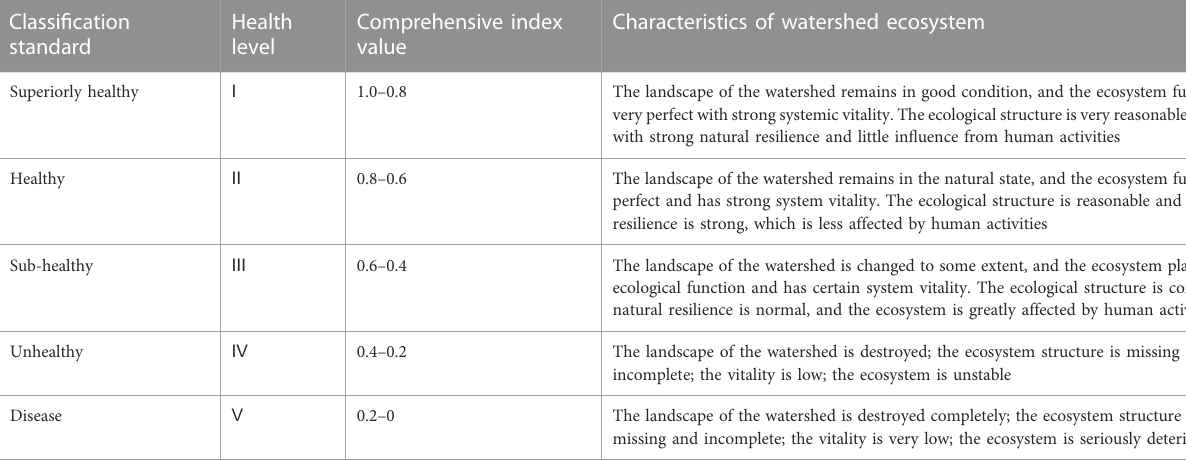
TABLE 5 Classi fi cation of comprehensive ecosystem